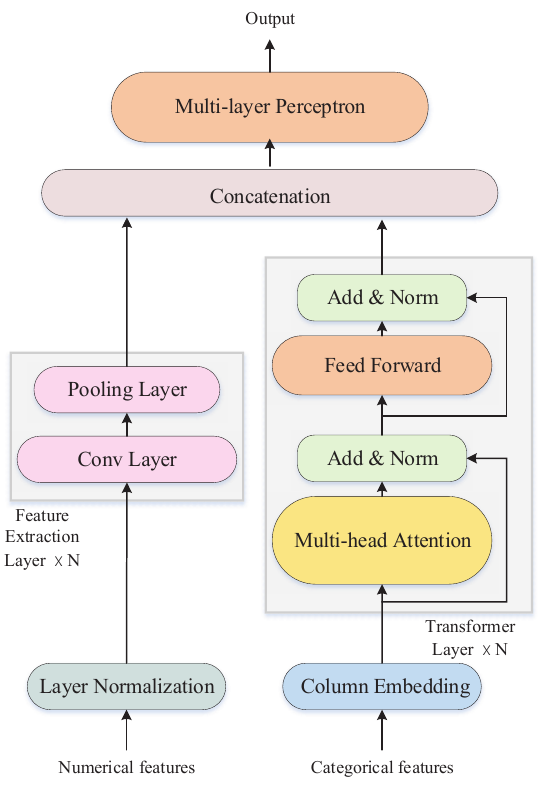
Figure 3. The architecture of